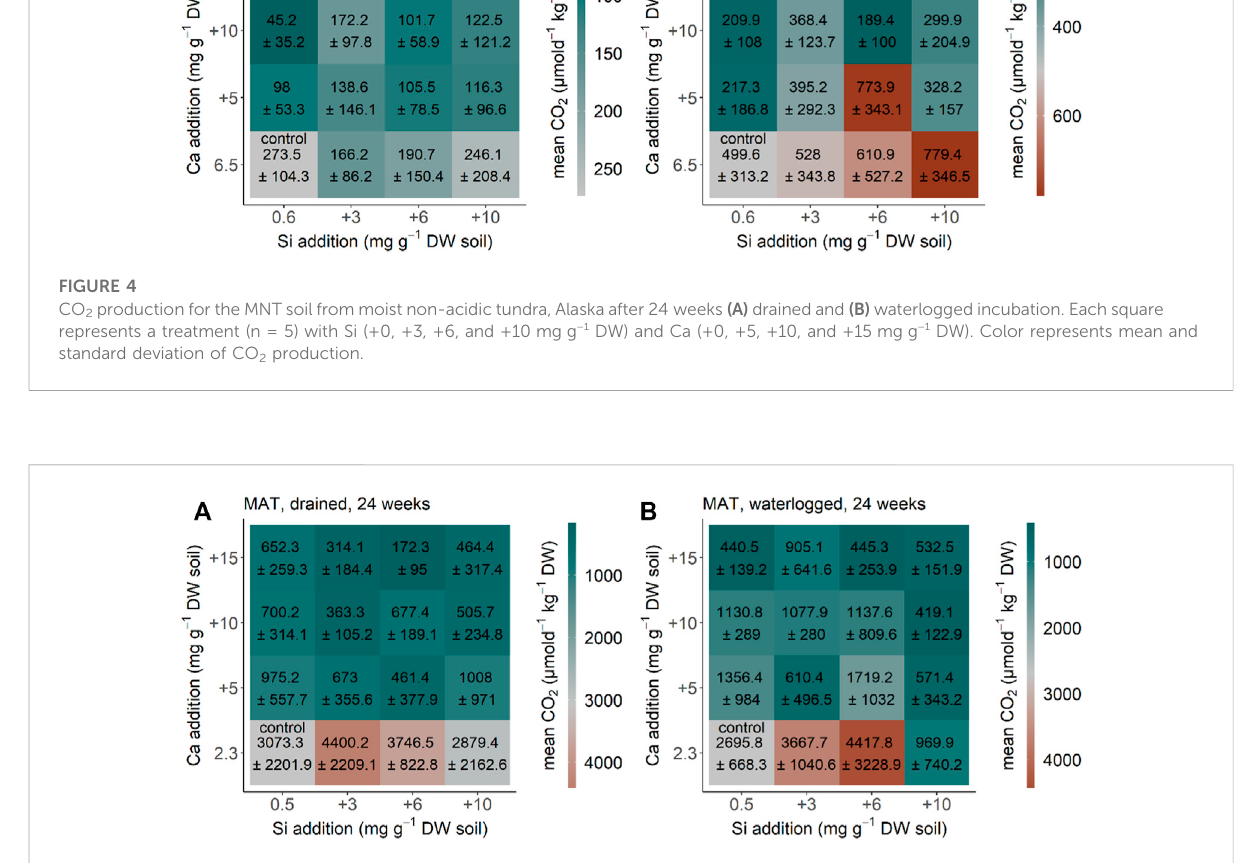
FIGURE 5 CO 2 production for the MAT soil from moist acidic tundra, Alaska after 24 weeks (A) drained and (B) waterlogged incubation. Each square represents a treatment (n = 5) with Si (+0, +3, +6, and +10 mg g − 1 DW) and Ca (+0, +5, +10, and +15 mg g − 1 DW). Color represents mean and standard deviation of CO 2